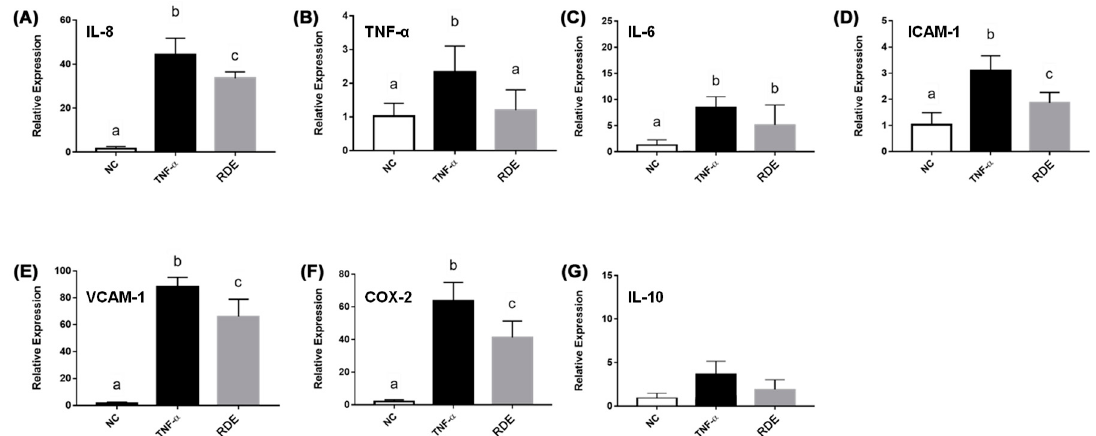
Figure 8. Gene expression of inflammatory mediators in no treatment (NC), TNF- α treated (TNF- α ), or RDE then TNF- α treated (RDE) EA.hy926 cells in the Caco-2 BBe1 / EA.hy926 co-culture model. Caco-2 BBe1 cells on the apical compartment were supplemented with 100 µ g / mL RDE for 1 h, followed by a 2 ng / mL incubation of TNF- α on the EA.hy926 cells for 4 h. The gene expressions of ( A ) IL-8, ( B ) TNF- α , ( C ) IL-6, ( D ) ICAM-1, ( E ) VCAM-1, ( F ) COX-2, and ( G ) IL-10 are shown. Values are presented as means ± SEM, n = 4. Shared letters indicate no significant di ff erence ( p > 0.05).